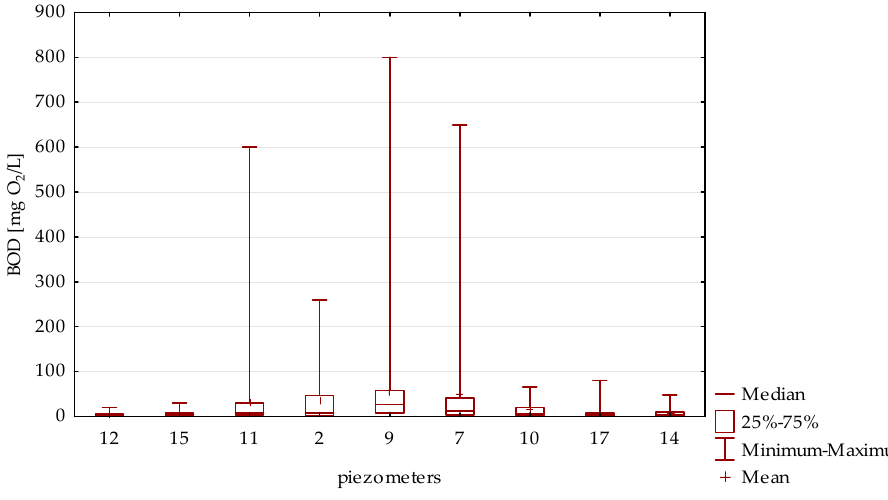
Figure 15. Box-and-whisker plots of the BOD level in particular piezometers.